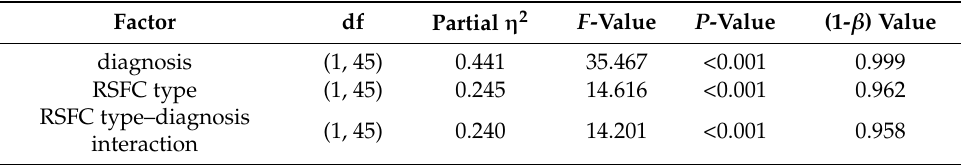
Table 2. Main effect of diagnosis, main effect of RSFC type, and type–diagnosis interaction revealed by two-way ANOVA for HbO 2